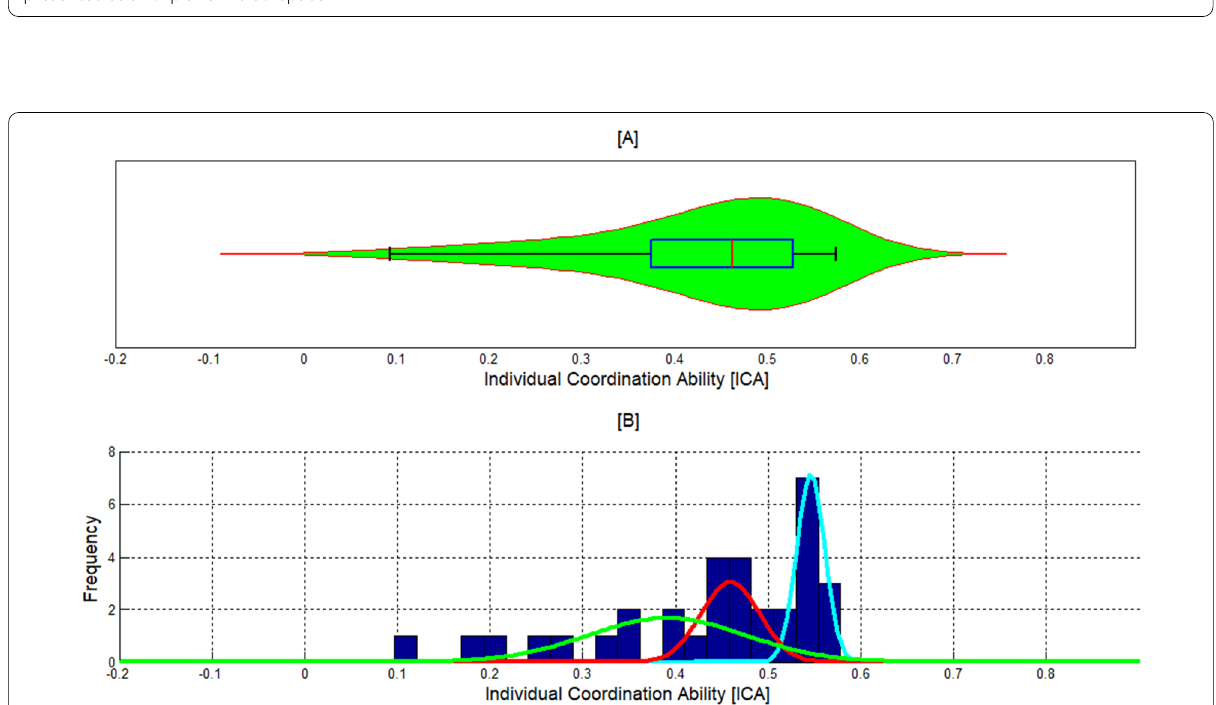
Fig. 5 The regression model in a 3D space. A multi-variable regression model that describes the relationship between the three SR variables and iCA. Each dot represents the iCA value of each player as a function of their strategic profile after data compression (3D to 2D). The new model is presented as a 2D plane in a 3D space